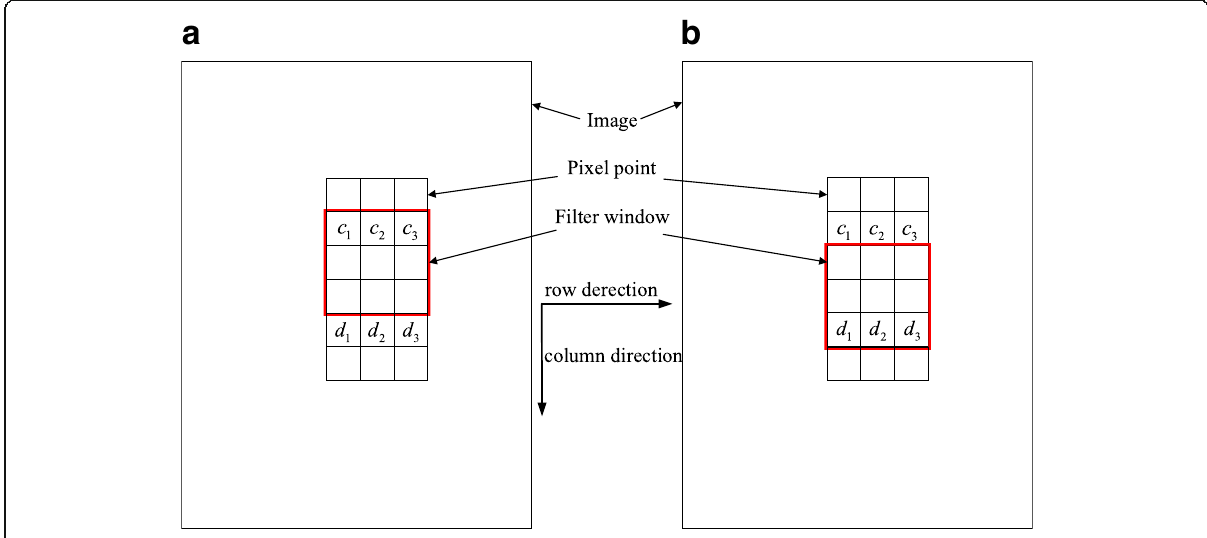
Fig. 5 Schematic diagram of filtering process. a Position relation before filtering. b Position relation after